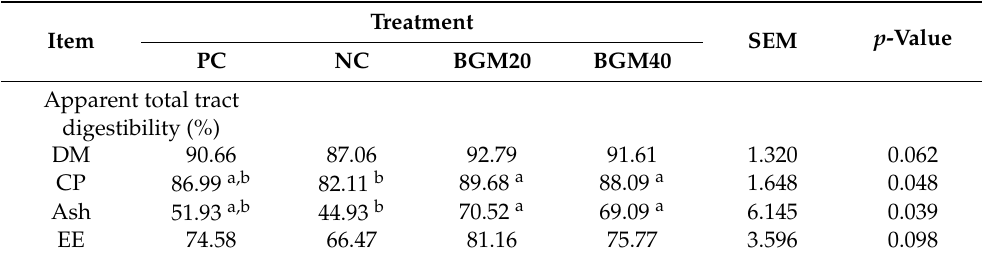
Table 3. Effect of dietary BGM with combined enzymes inclusion on nutrient digestibility of growing pigs 1